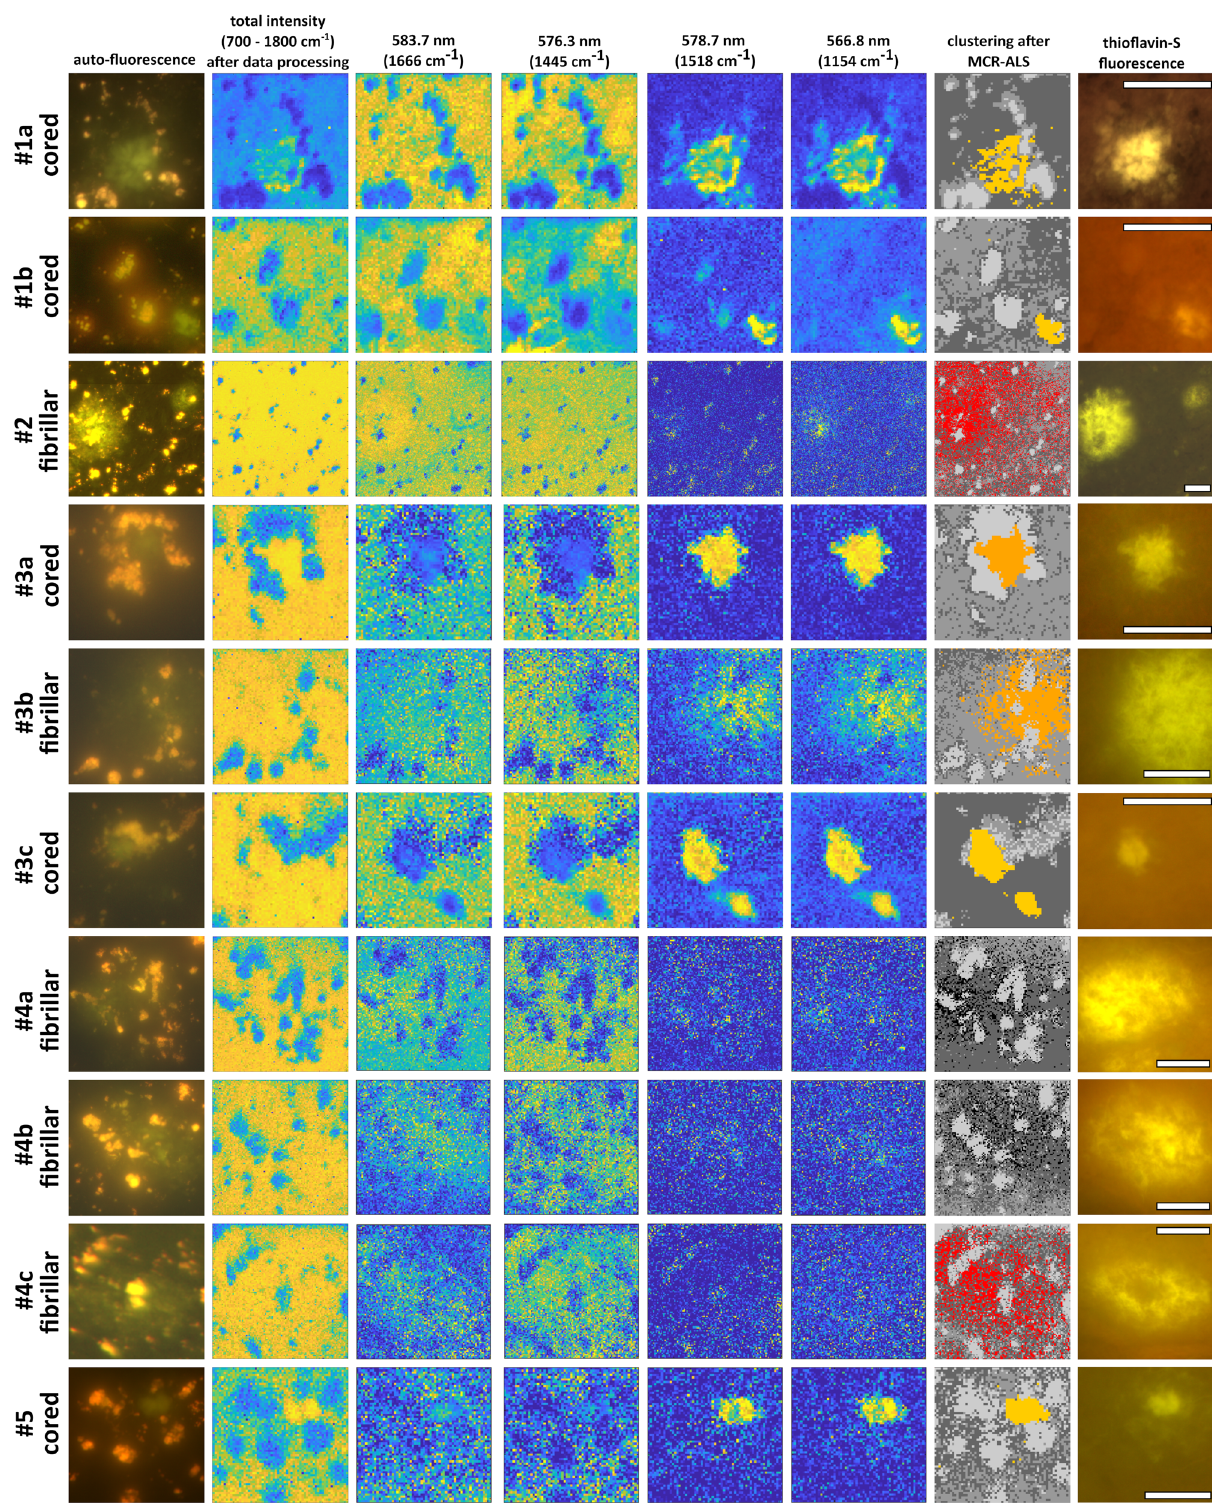
Fig. 5 Overview of fl uorescence and Raman images. Each row represents one tissue section. First column: Auto- fl uorescence images of the presumed plaque (green) areas. Second column: The total intensity image of the spectral Raman data after data pre-processing. Third and fourth column: Raman peak intensity images of the protein (1666 cm − 1 ) and lipid (1445 cm − 1 ) bands. Fifth and sixth column: Raman peak intensity images at two prominent carotenoid wavenumbers (1518 and 1154 cm − 1 ). Seventh column: four-cluster images of the Raman data after MCR-ALS computing, highlighting the plaque locations in orange (#1) and red (#2 and #4c). Last column (eighth): Fluorescence image of the thio fl avin-S stained tissue, con fi rming anticipated plaque locations by yellow fl uorescence. Note for cored plaques #1a, #1b, #3a, #3c, and #5 how well the carotenoid peak images and the cluster analysis match the stained plaque depositions. Scale bars: 40 µ m; color coding for columns 2 to 6: blue (low) to yellow (high).